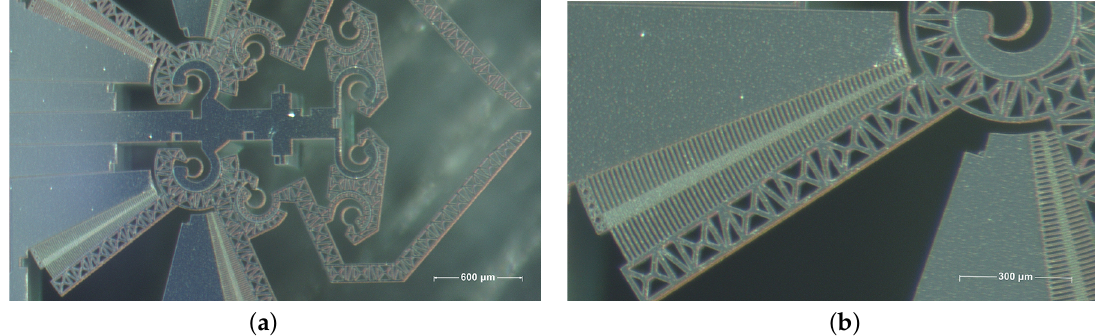
Figure 1. Image of a microgripper prototype obtained from optical microscope ( a ) and a detail of the rotary comb-drive ( b